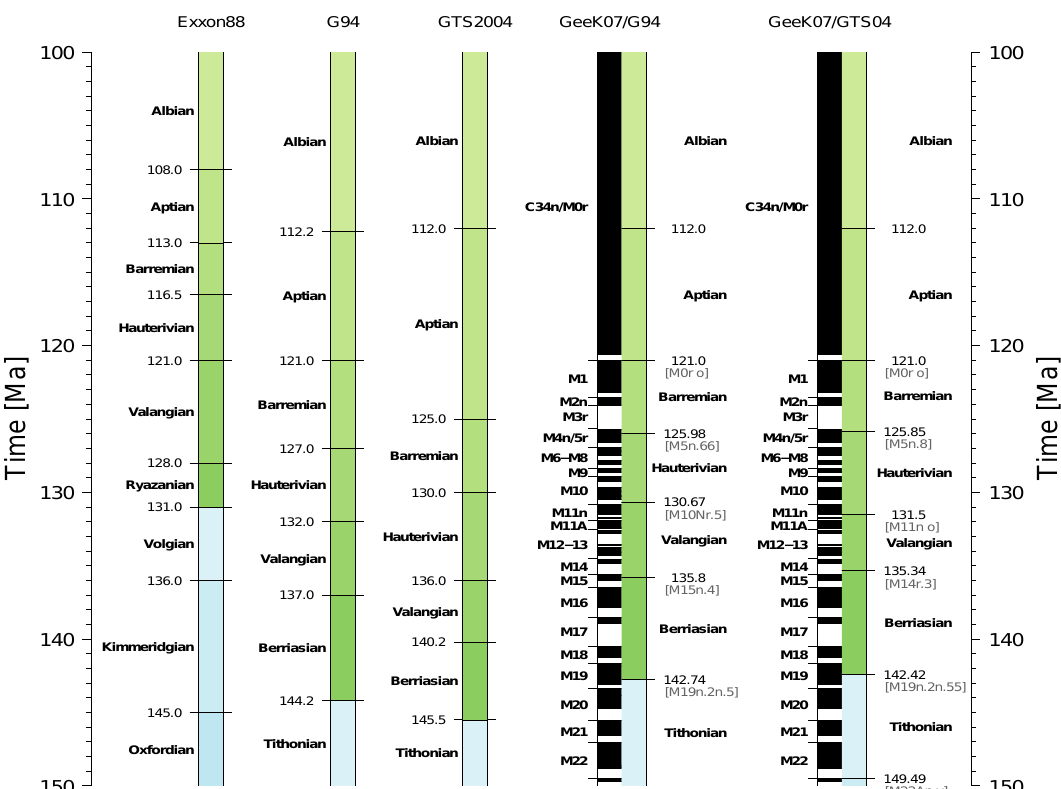
Fig. 2. Comparison of the timescales used in publications related to the South Atlantic marginal basins and the African intraplate basins. GeeK07 is Gee and Kent (2007), Exxon88 is Haq et al. (1987), G94 is Gradstein et al. (1994) and GTS2004 is Gradstein et al. (2004). GeeK07+GTS04 and GeeK07+G94 show magnetic polarity timescale with stratigraphic intervals from GTS04 and G94, respectively, ad- justed to tie points annotated on the right hand side of the stratigraphic columns (grey font), where ∗ .N indicates the relative position from the base of the chron (e.g base Barremian at 125.85Ma – base M4n